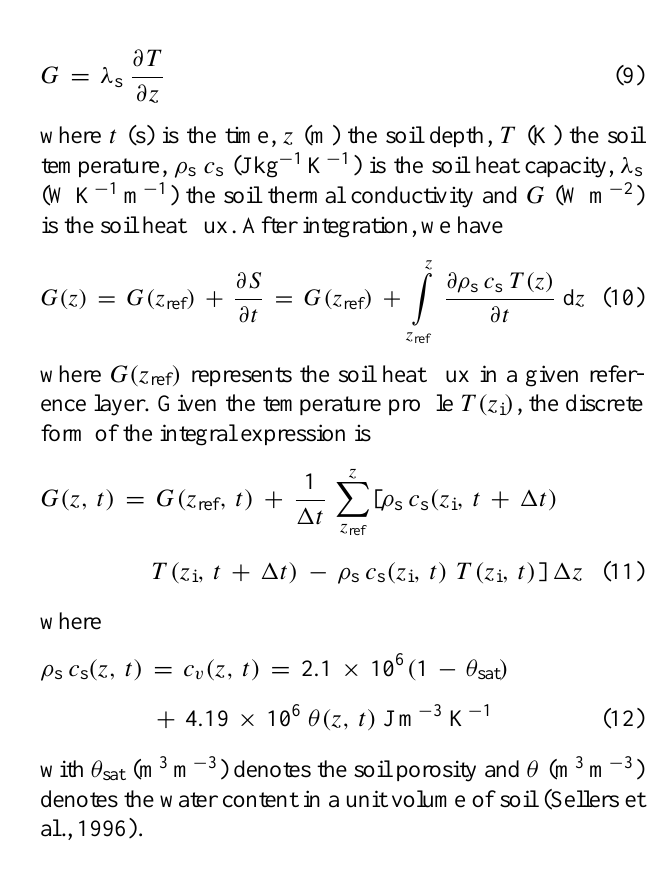
Fig. 3. Seasonally averaged diurnal cycle of the components of air-space storage heat flux over the native grassland of the semi-arid Loess Plateau in (a) spring, (b) summer, (c) autumn, and (d) winter. Where S T is the sensible heat storage flux, S q is the latent heat storage